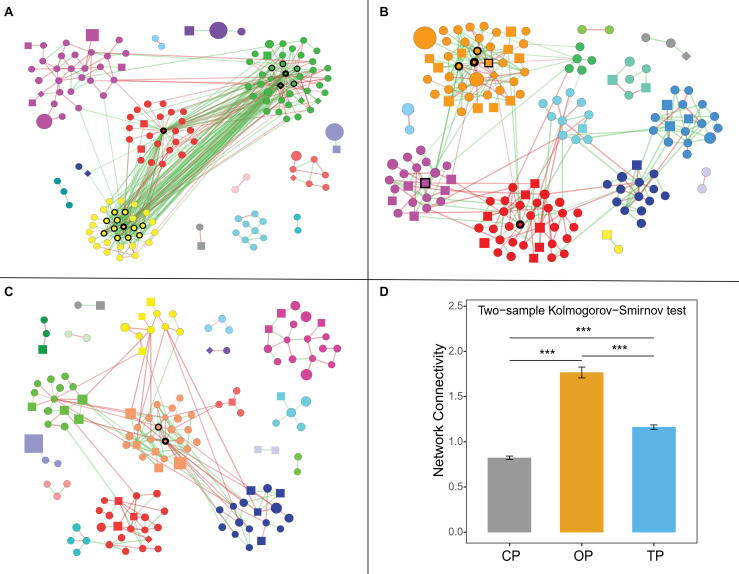
Farming-specific co-occurrence networks of (A) organic, (B) transition, and (C) conventional farming practices. Green and red colors of the edges represent positive and negative relationships, respectively, while the color of nodes demonstrates network modules. The shape of vertices reflects microbial domains (i.e., circle: bacteria; square: fungi; and diamond: archaea), and the size of nodes refers to abundances. In addition, the nodes with black borders were assigned as hub taxa, and the width of the border reflects the node degree score. Note: only nodes with at least 1 connection are visualized. (D) Network connectivity or node degree represents the number of edges connected to a node. The symbol (***) represents statistical significance of p-value < 0.0001.